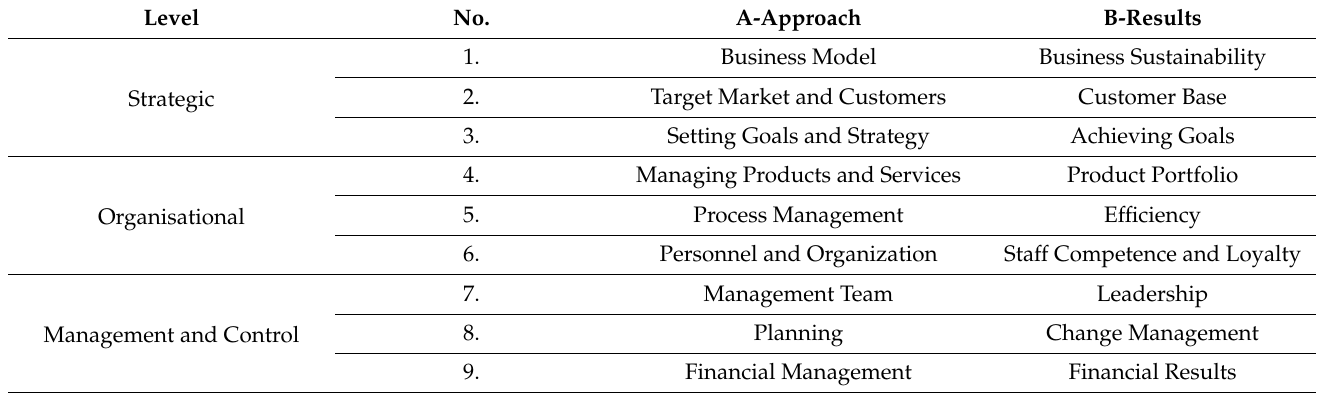
Table 1. The owner-managed SME governance